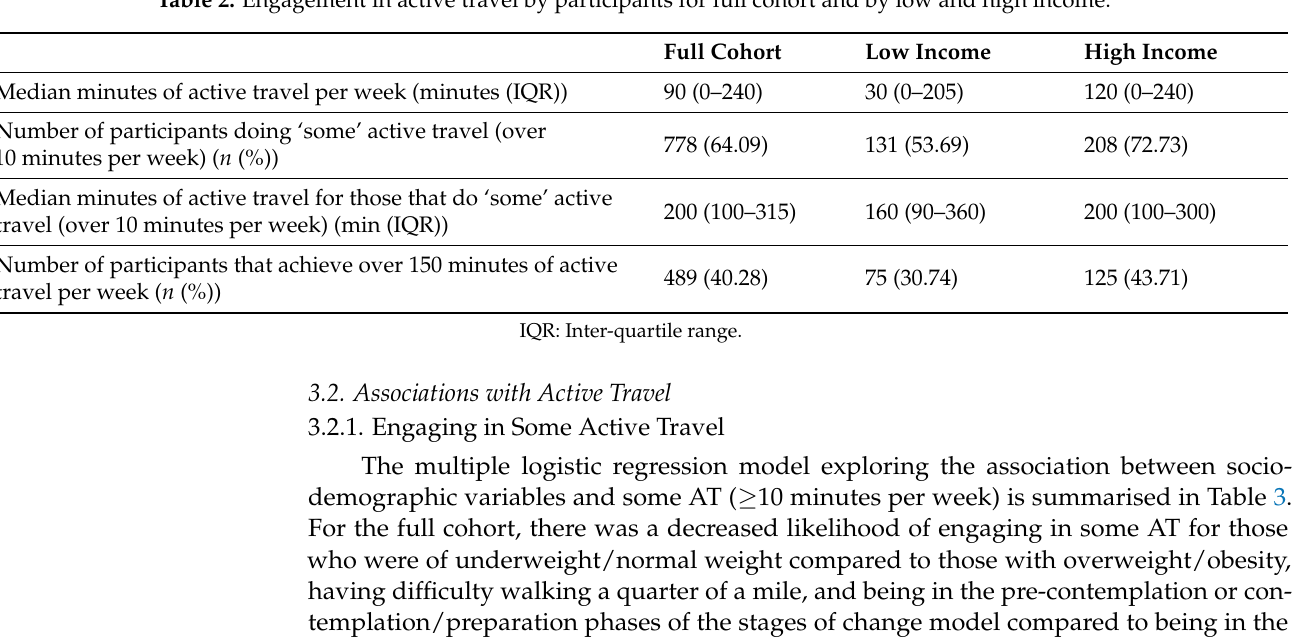
Table 2. Engagement in active travel by participants for full cohort and by low and high